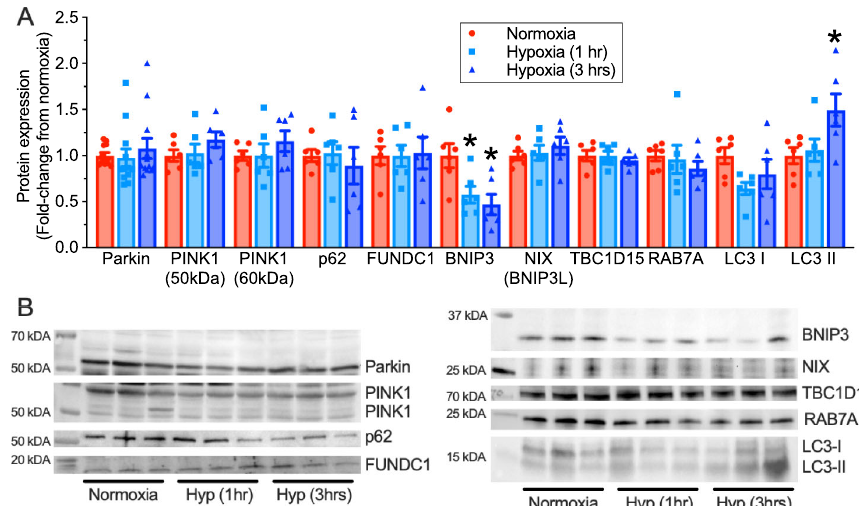
Fig. 6 Hypoxia does not alter the expression of key mediators of ubiquitin- or receptor-mediated mitophagy. A Summary of changes in receptor- mediated mitophagy-related protein expression in interscapular BAT (iBAT) homogenates from naked mole-rats held at 30 °C in normoxia (21% O 2 , red bars) or after 1 or 3 h of hypoxia (7% O 2 , light and dark blue bars, respectively; n = 12 biologically independent samples for Parkin and 6 biologically independent samples for all other proteins). B Western blot images of protein bands from ( A ). Data are mean ± SEM. Asterisks indicate signi fi cant difference from normoxic controls (one-way ANOVA with Tukey multiple comparisons test; F 2,15 = 6.16, p = 0.0111 for Bcl-2 adenovirus E1B 19 kDa- interacting protein 3 (BNIP3); F 2,12 = 4.14, p = 0.0441 for light chain 3 II (LC3II); p > 0.05 for FUN14 domain containing 1 (FUNDC1), sequestosome 1 (p62), phosphatase and tensin homolog (PTEN)-induced kinase 1 (PINK1), ras-related protein 7A (RAB7A), and TBC1 domain family member 15 (TBC1D15)).